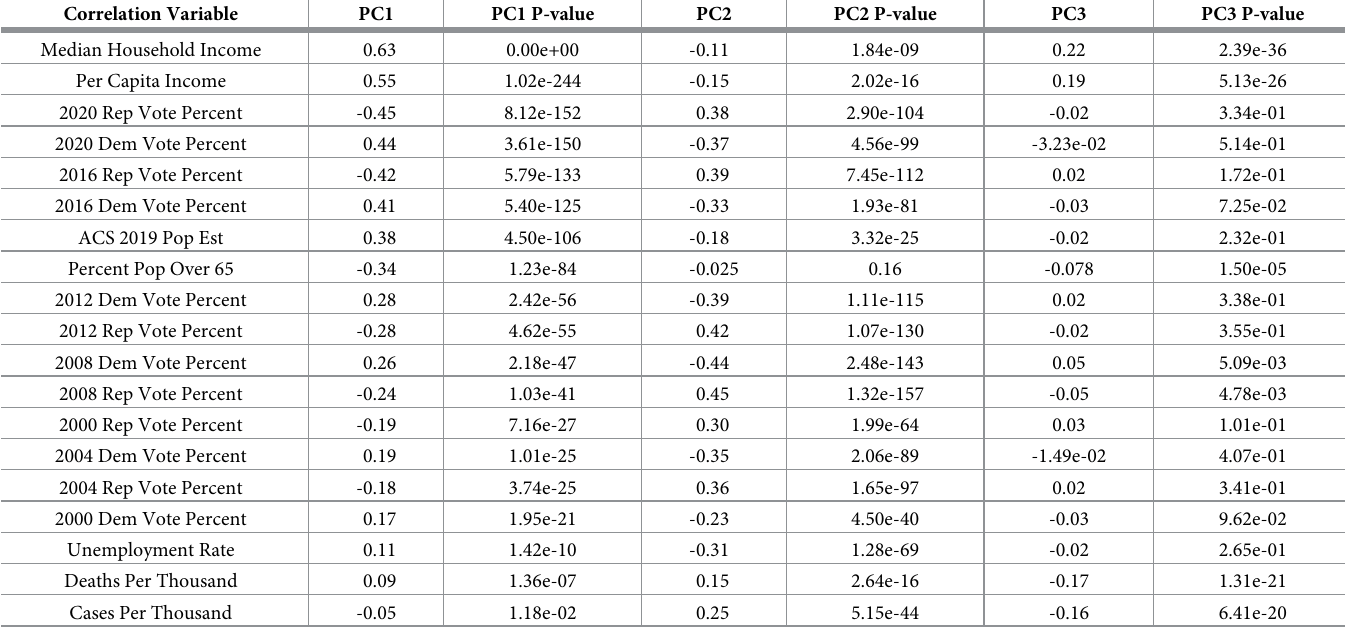
Table 3. Correlation analysis results showing Pearson’s correlation and respective p-values between each principal component (PC1-PC3) and other population